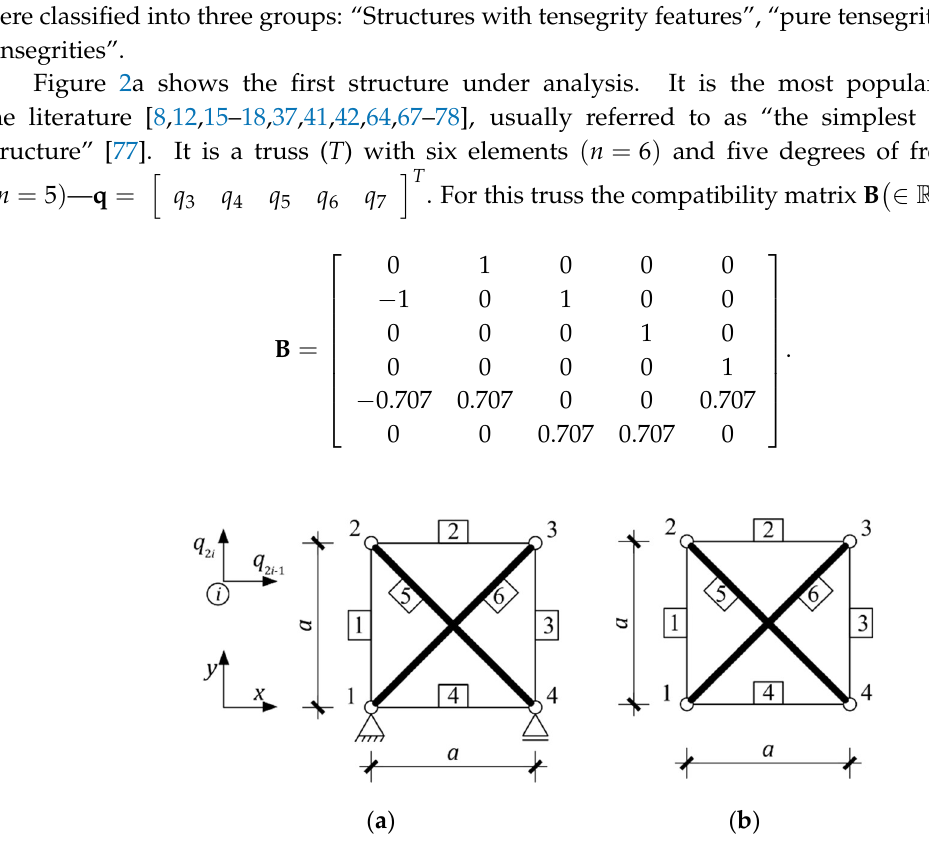
( c ) Figure 3. Mechanisms of unsupported “X” truss: ( a ) 𝐱 (cid:2875) , ( b ) 𝐱 (cid:2876) , ( c ) 𝐱 (cid:2877) . There are four structures with similar features wrongly termed “tensegrity” in the literature: 